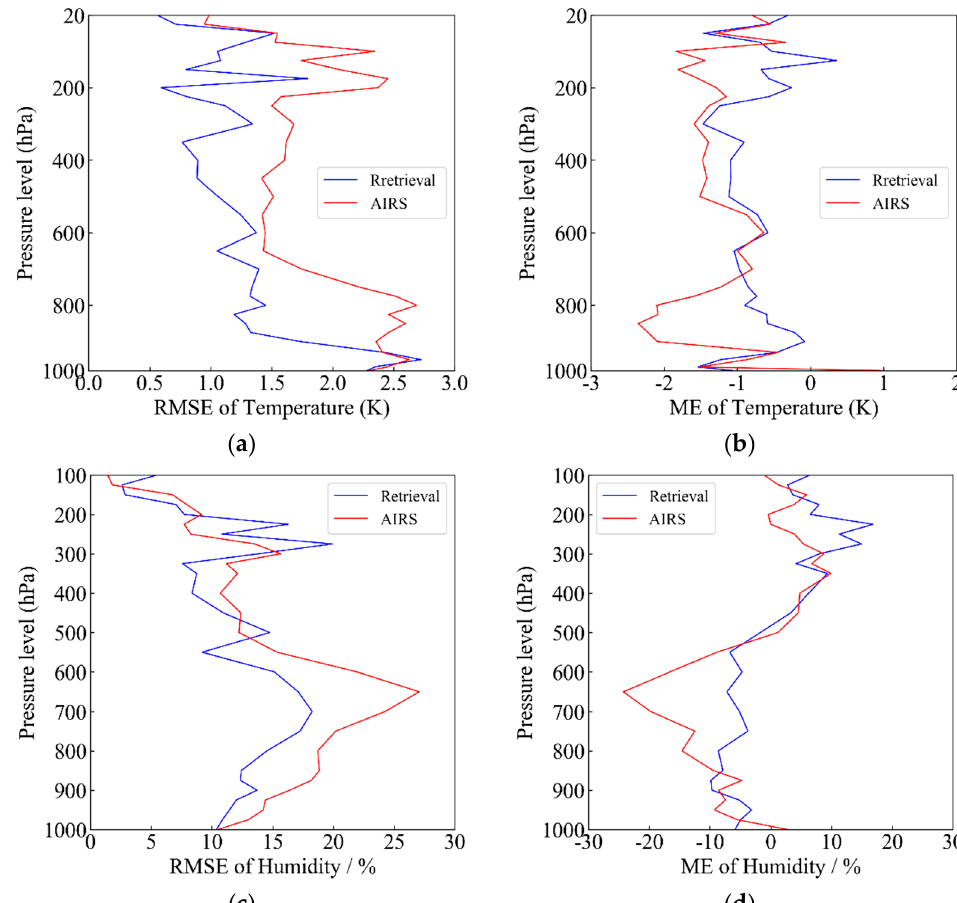
Figure 15. Comparison of the retrieval profile with the AIRS product. ( a ) Temperature RMSE, ( b ) temperature ME, ( c ) humidity RMSE, and ( d ) humidity ME.